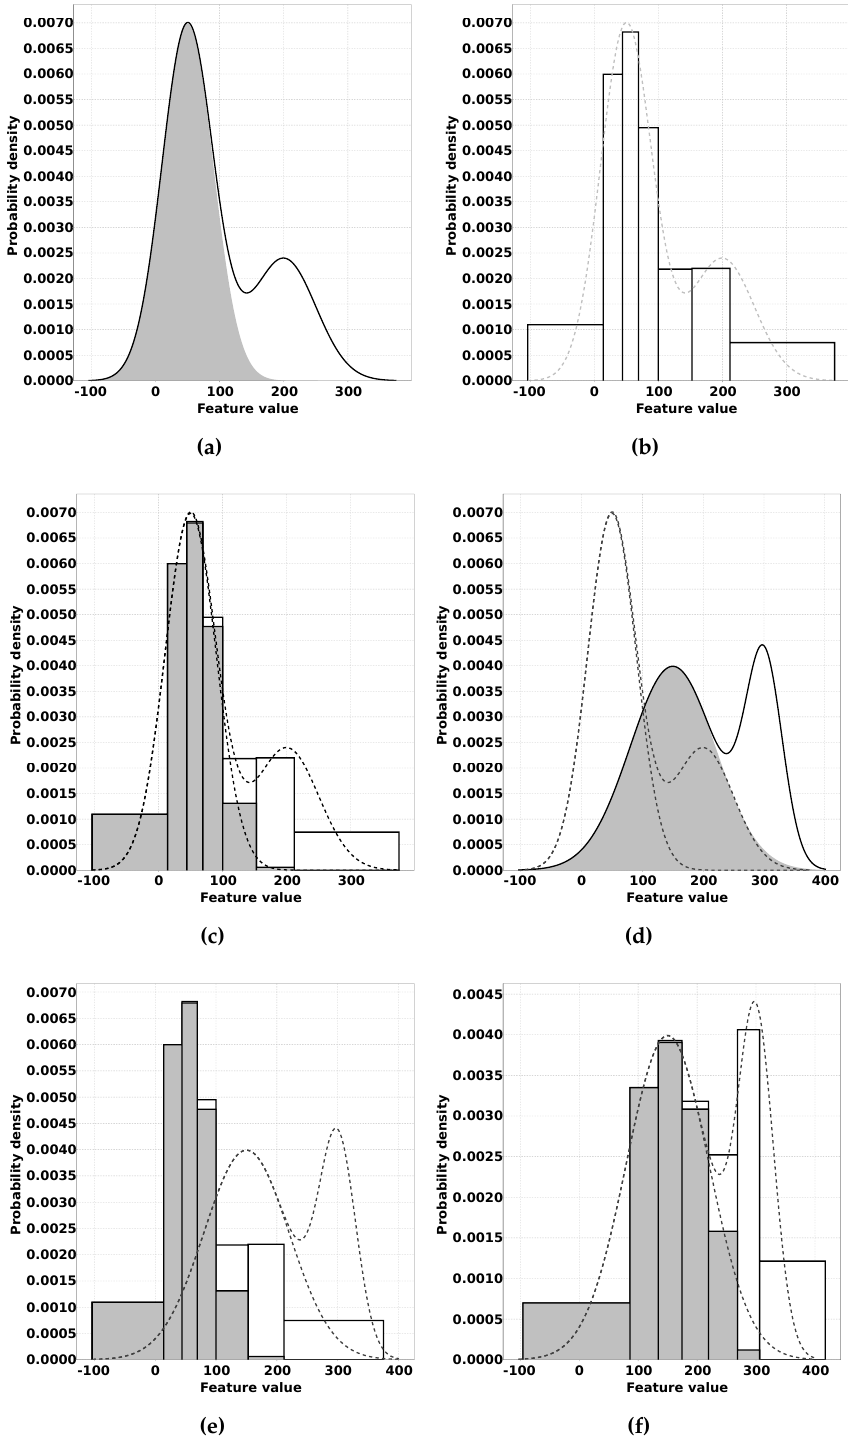
Figure 1. Visualisation of the offline phase of QUEST (QUantile Estimation after Supervised Training). Gray and white areas represent different desired output classes. ( a ) Example distribution; ( b ) The x -axis is divided in intervals using an unsupervised learning heuristic. The borders lie on i 1 . . . i 6 , i n is the 1 quantile; ( c ) The distribution of classes, is empirically estimated for each quantile; ( d ) A different n data distribution encountered by a sensor node running QUEST, the original distribution is shown as dashed lines; ( e ) Initially, the distribution of the quantiles for the classifier does not match the new distribution; ( f ) QUEST applies an unsupervised learning heuristic to update the quantiles for the modified